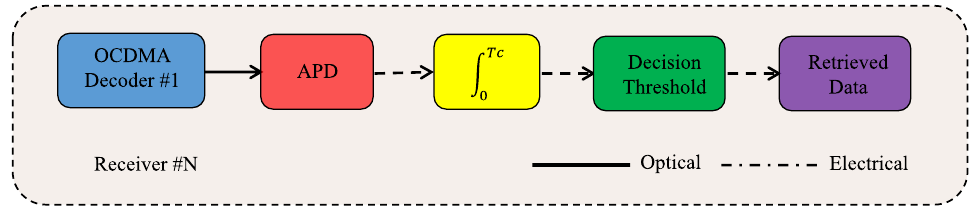
Figure 2. Block diagram of the decoder at the receiver side showing the OCDMA decoder, the avalanche photodetector (APD), the integrator with T c as chip duration, the threshold deci- sion device, and recovered